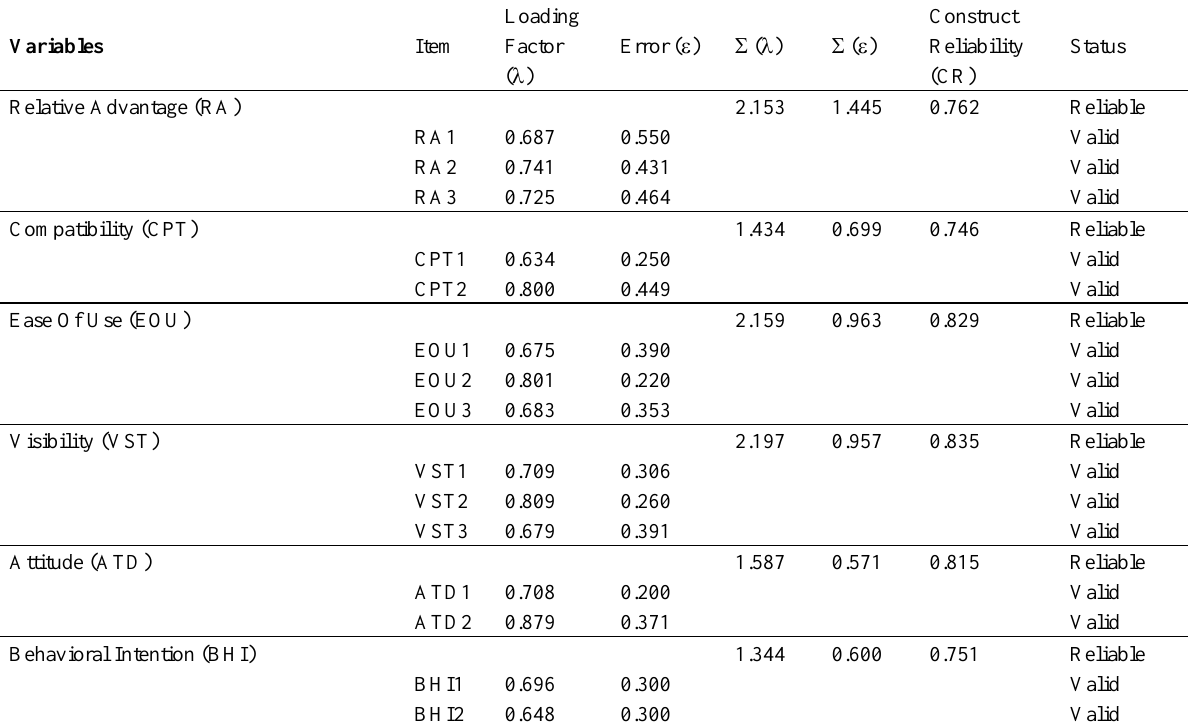
Table 2: Reliability and validity of the variables and items